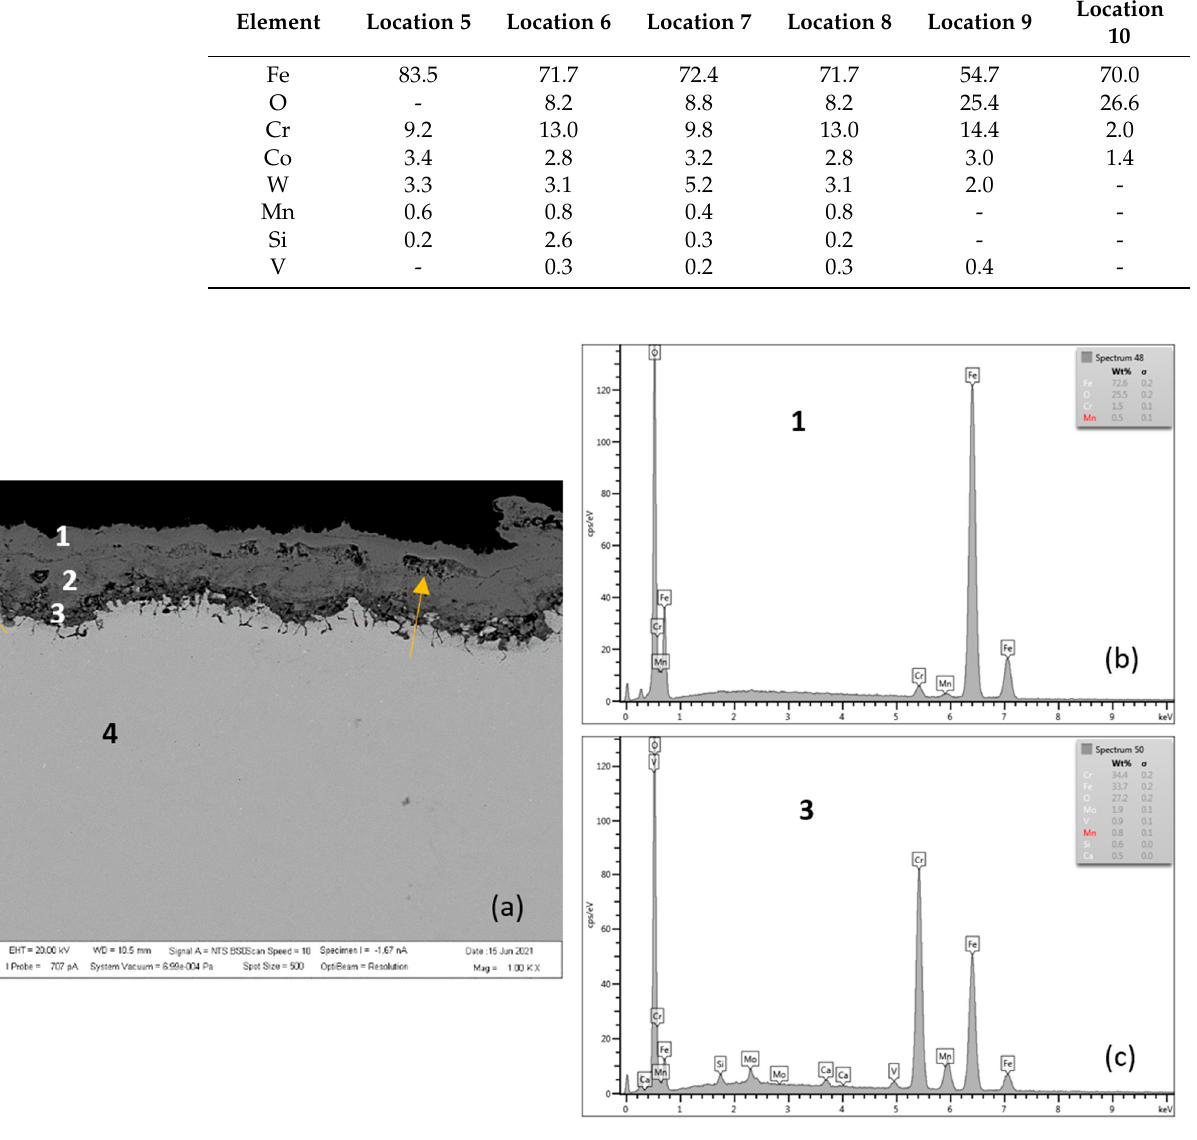
Figure 4. P91 after 2000 h at 600 °C ( a ), EDX analysis from location 1 ( b ) (outer oxide layer), and location 3 ( c ) (interface substrate/oxide layer). Table 3. Quantitative EDX analysis, sample P91 oxidized at 600 °C for 2000 h (in wt.%).